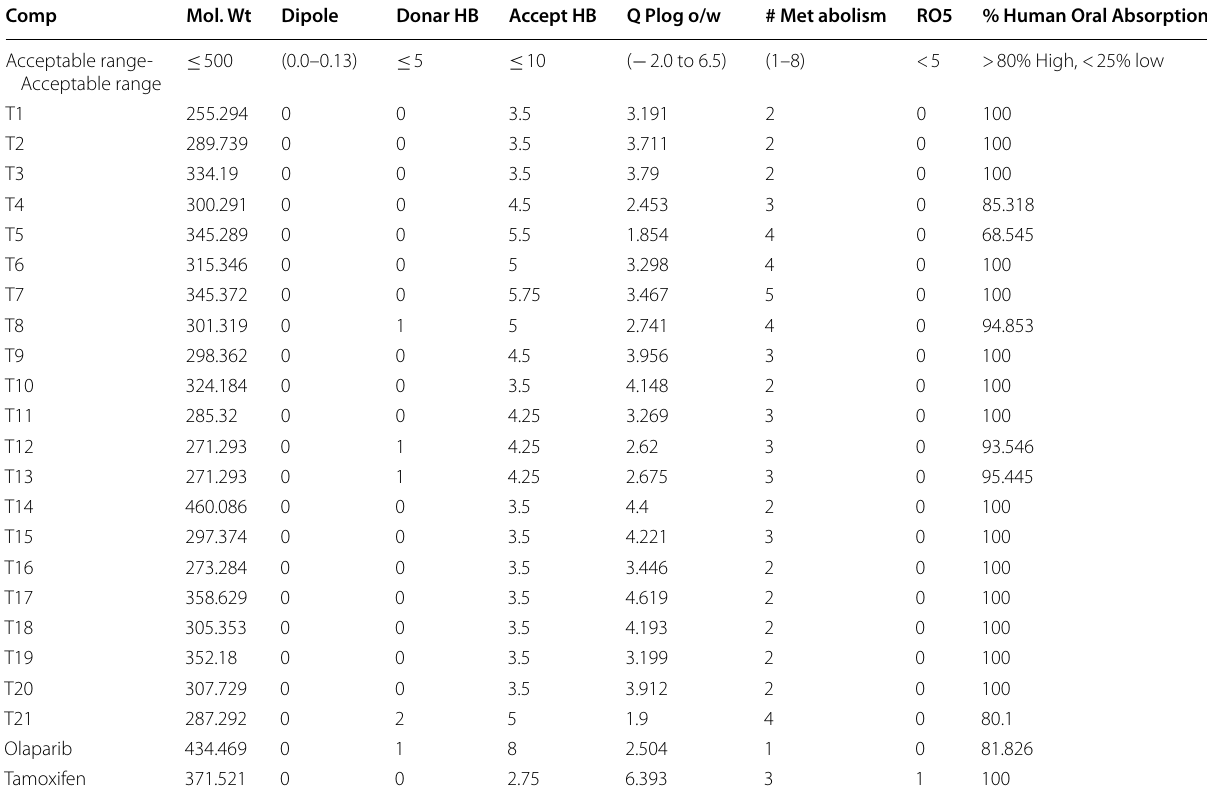
MW, Molecular weight of the molecule; Dipole, Computed dipole moment; Donor HB, Estimated number of hydrogen bonds that would be donated by the solute to water molecules in an aqueous solution; Accept HB, Estimated number of hydrogen bonds that would be accepted by the solute from water molecules in an aqueous solution; QP logPo/w, Predicted octanol/water partition coefficient; # metab, Number of likely metabolic reactions; Rule of Five Number of violations of Lipinski’s rule of five; %Human- Oral absorption, Predicted human oral absorption on 0 to 100% scale